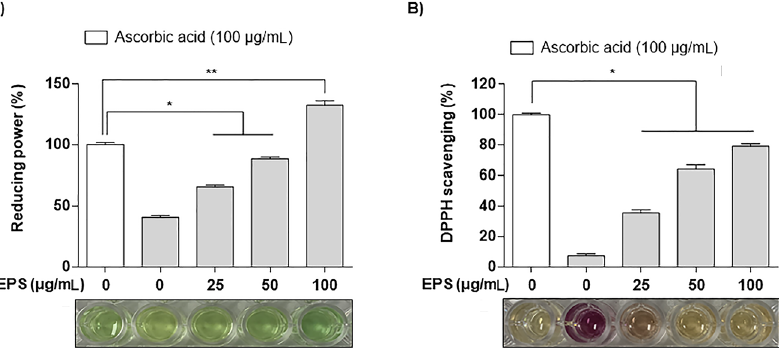
Figure 1: Antioxidant (Reducing power, DPPH) activities of ethanol extract of P. senticosum